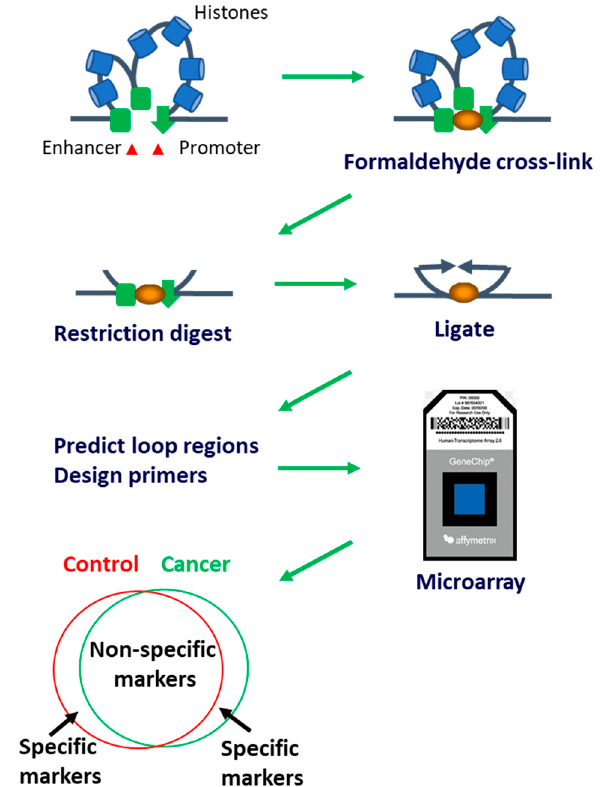
Figure 1. Scheme of chromatin conformation assay and microarray analysis. A three-dimensional structure of chromosomes contains loops with an enhancer and promoter regions, whereas the enhancer increases target gene promoter activity. CC capture assay: DNA is cross-linked using formaldehyde, digested, and ligated with the preference of cross-linked fragments. New sequences are formed where the loops have been. These new sequences are predicted via relevance machine vector algorithm. Specific primers to these sequences are synthesised and placed on the DNA microarray, which detects whether the loop was present or not. Resulting markers are analysed using multivariate analysis yielding specific epigenetic signatures for selected patient cohorts.